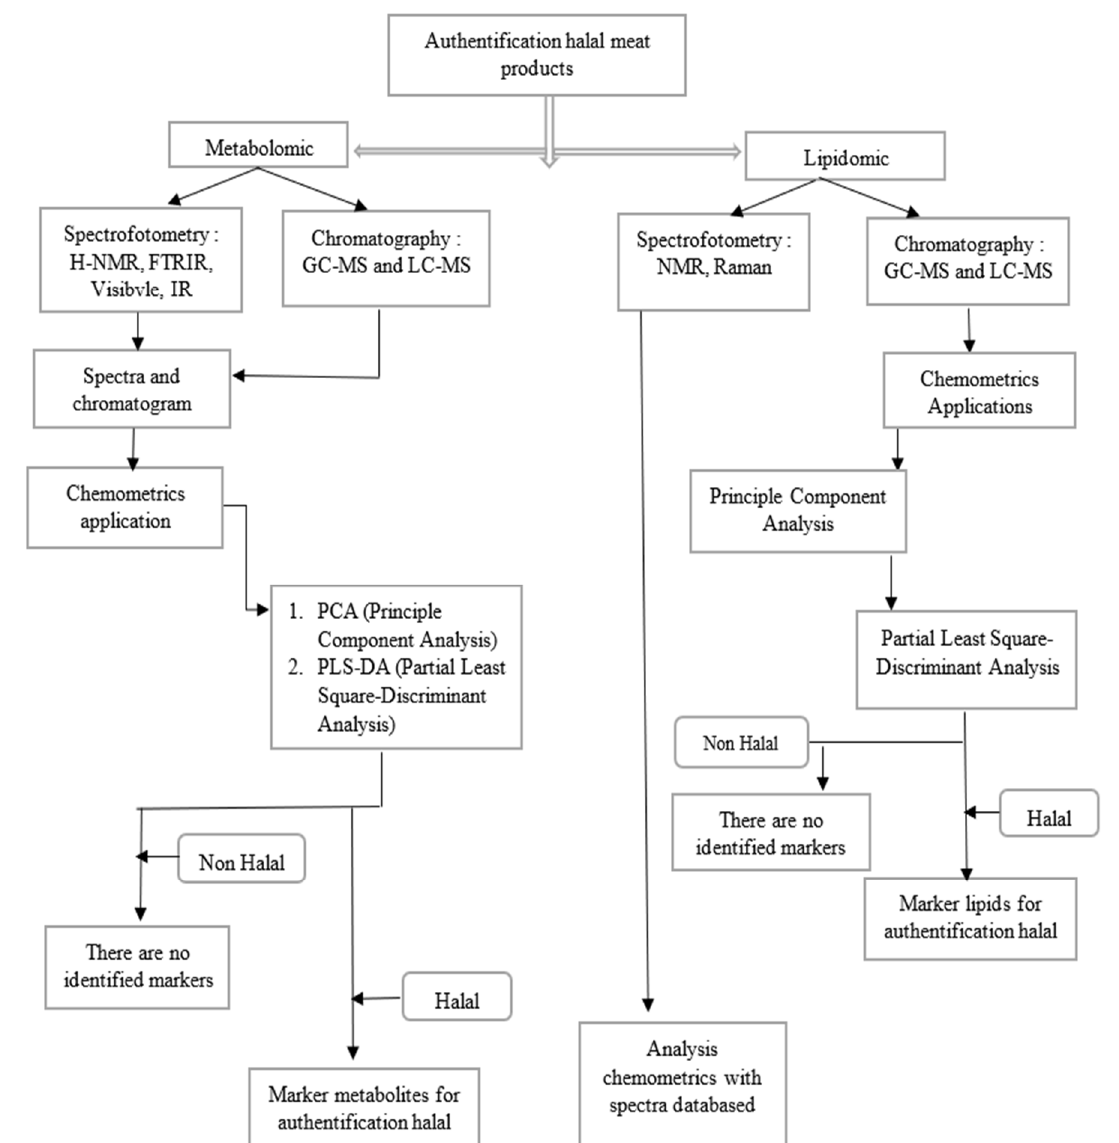
Figure 3. Chemometrics applications in metabolomic and lipidomic studies for halal authentication in meat products.